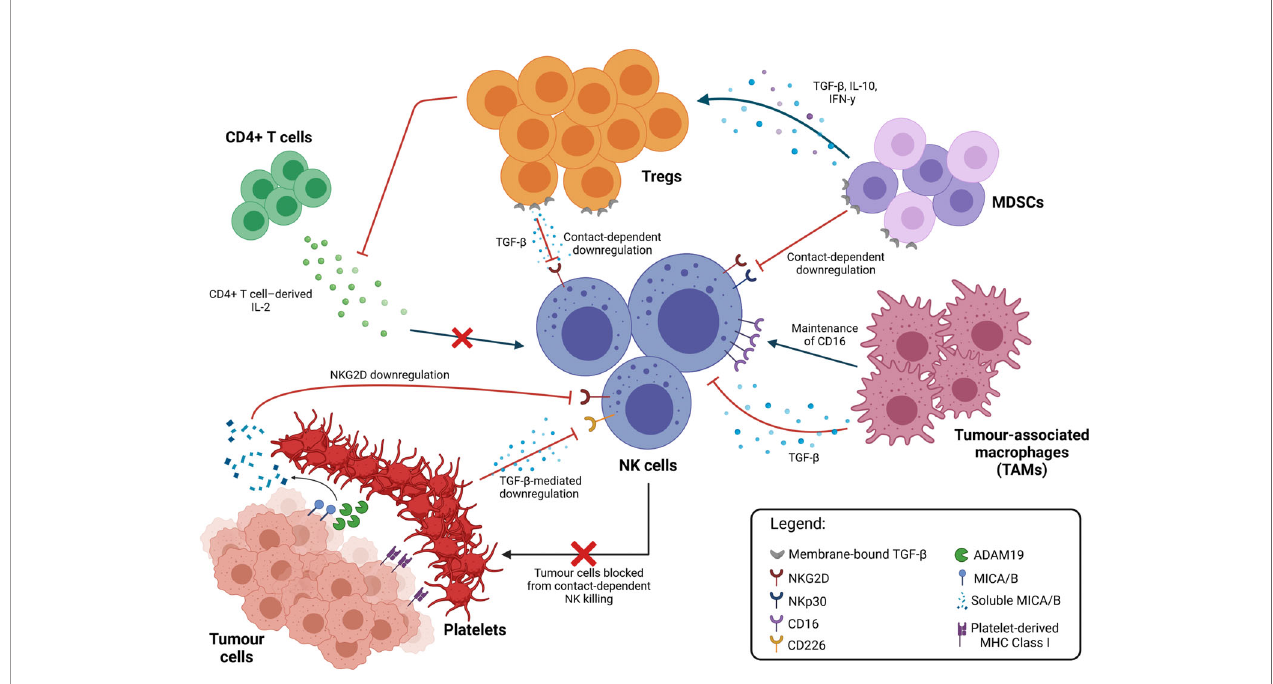
FIGURE 2 | Inhibition of NK cell cytotoxicity by other immune cells. Immune suppressive cell types in the TME interact directly with NK cells to inhibit their function through both contact-dependent and contact-independent downregulation of NK cell activating receptors, typically mediated by TGF- b . TAMs promote the maintenance of membrane-bound CD16, which reduces NK activation. NK cell function can also be modulated indirectly through multiple interactions between these different cell types. Cytokine secretion by MDSCs promote the expansion of Tregs, which apart from directly inhibiting NK cell functions, also limits the availability of IL-2 from CD4+ T cells, thus preventing NK cell stimulation. Platelets in the TME also interact with tumour cells directly, shielding them from NK cell recognition and killing; cleaving activating ligands on the tumour cell surface; and equipping tumour cells with MHC Class I molecules to facilitate immune